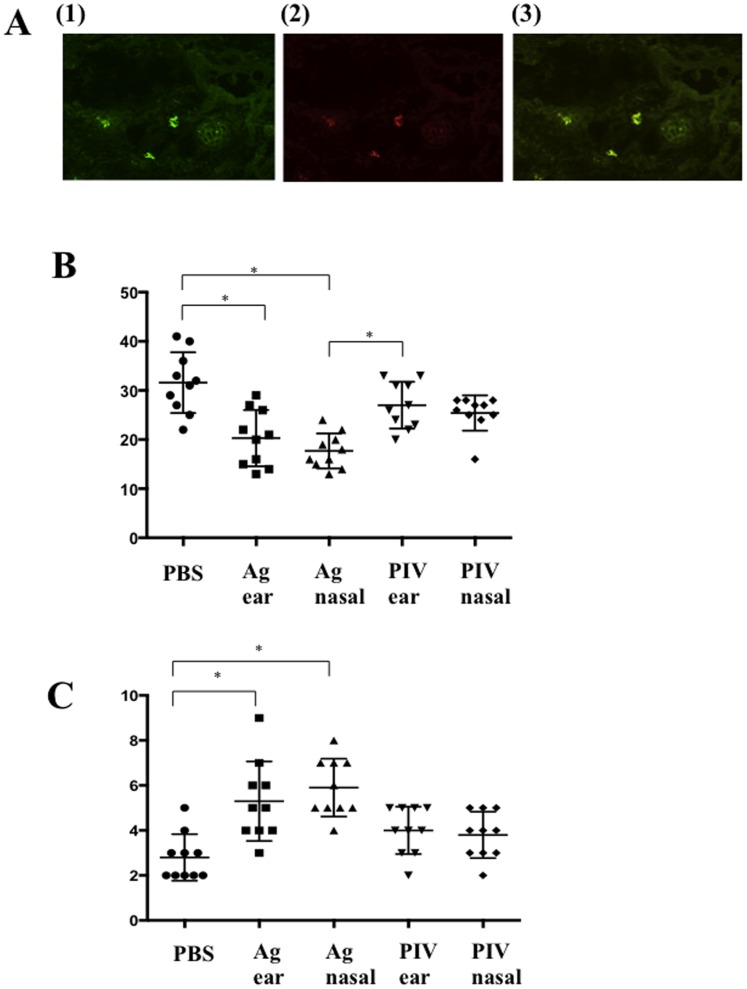
Immunostaining for Tregs in the inflamed ear skin lesions.
A. CD4+ T cells are displayed with green fluorescence (1), and Foxp3+ T cells are with red (2). Merged yellow color means Foxp3+CD4+ T cells (3) (x100). B. The number of skin infiltrating CD4+ T cells is less in Ag nasal group and Ag ear group compared to that of PBS-treated group. Although it does not reach statistical significance, CD4+ T cell number is less in Ag nasal group compared to that of Ag ear group. C. The number of Foxp3+CD4+ T cells in the inflamed ear skin is significantly increased in both of the intra-nasal and ear-subcutaneous rhPIV2/Ag85B application groups.